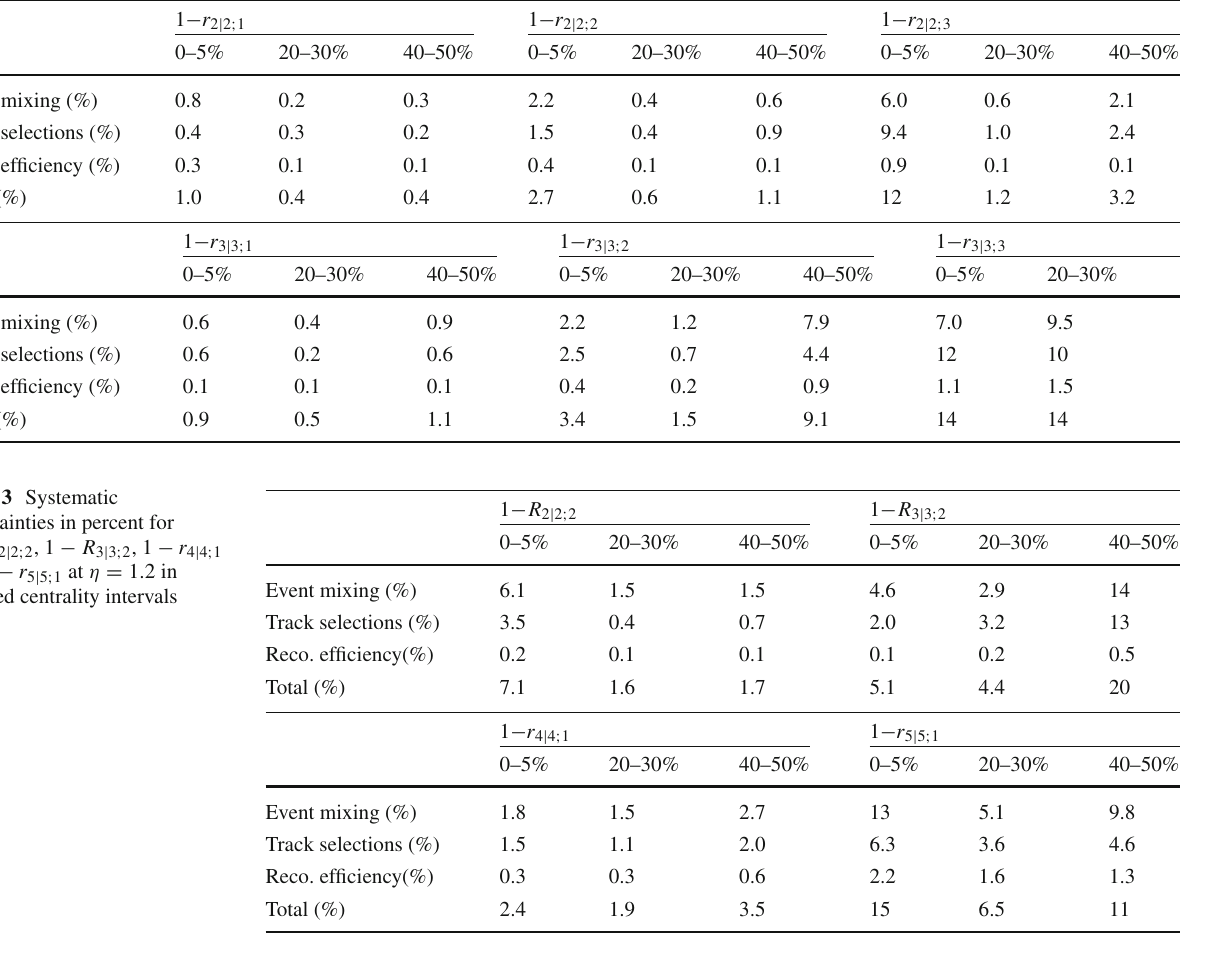
Table 2 Systematic uncertainties in percent for 1 − r 2 | 2 ; k and 1 − r 3 | 3 ; k at η = 1 . 2 in selected centrality intervals